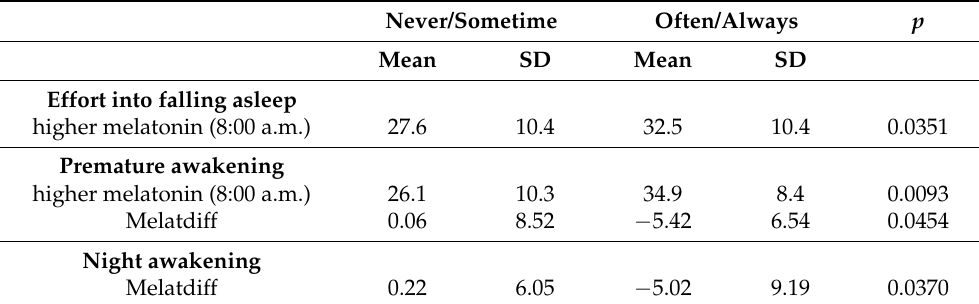
Table 3. Association of melatonin levels with sleep